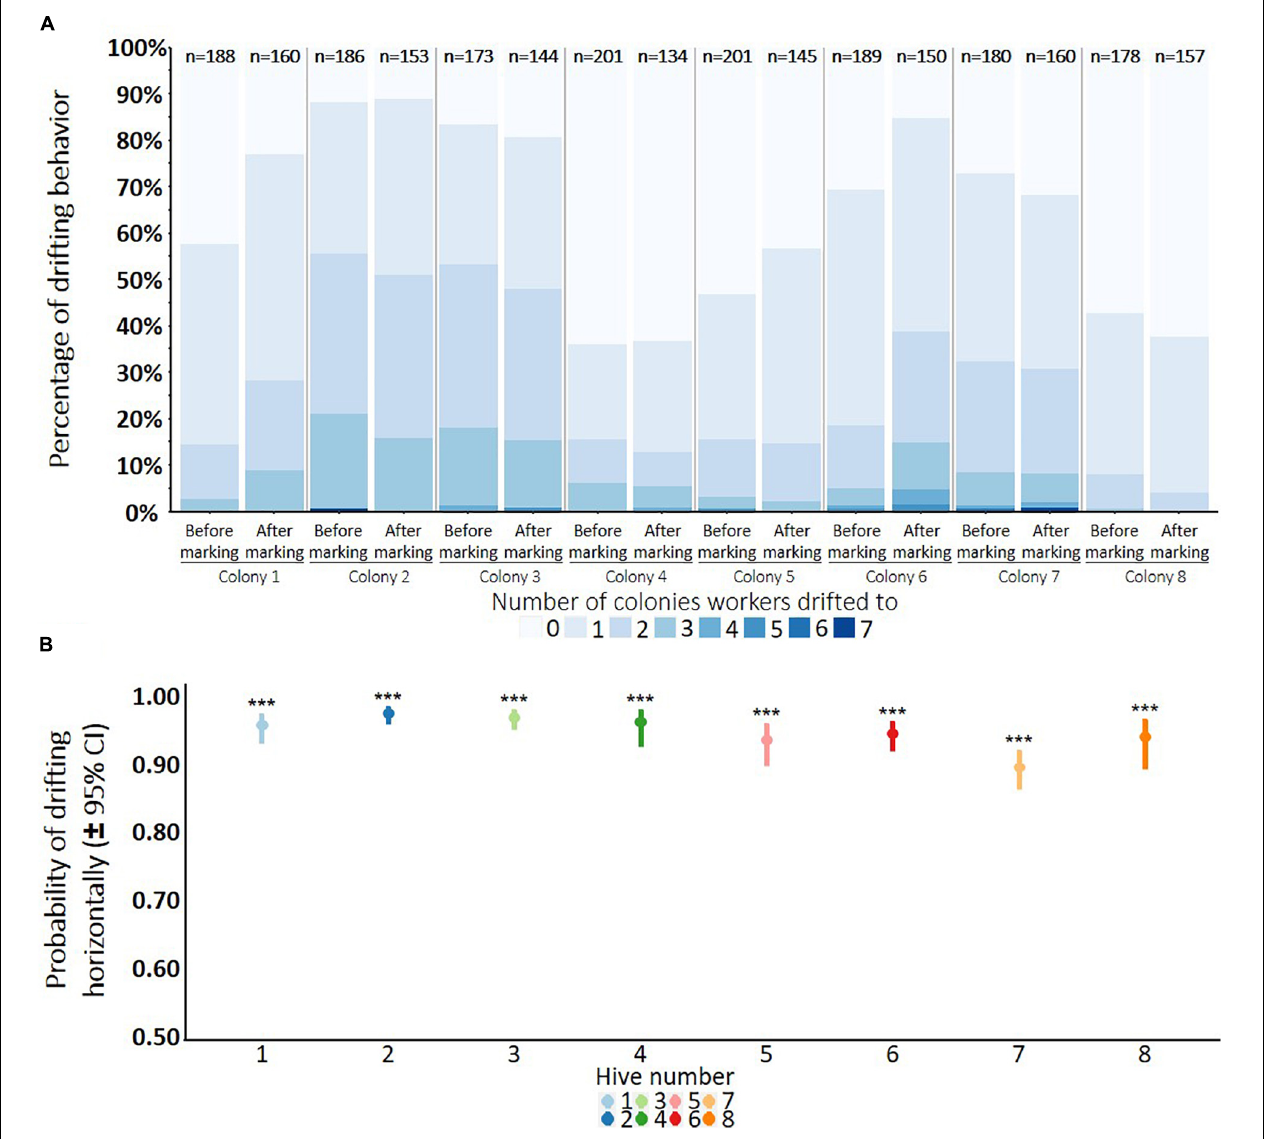
FIGURE 4 | (A) Percentages of drifting events to different foreign colonies during the experimental period before and after marking the colony entrances. Hives placed in the middle sections of the shelves presented higher rates of drifting behavior with some drifters visiting all seven non-natal hives. n shows the number of tagged worker drifters per colony per period. (B) Drifting events were mostly in the horizontal plane, with on average 96% of the drifting events being to colonies placed on the same shelf than the natal